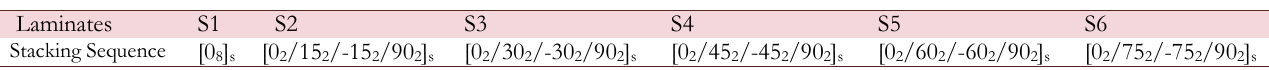
Table 4: Different stacking sequences used in the composite.